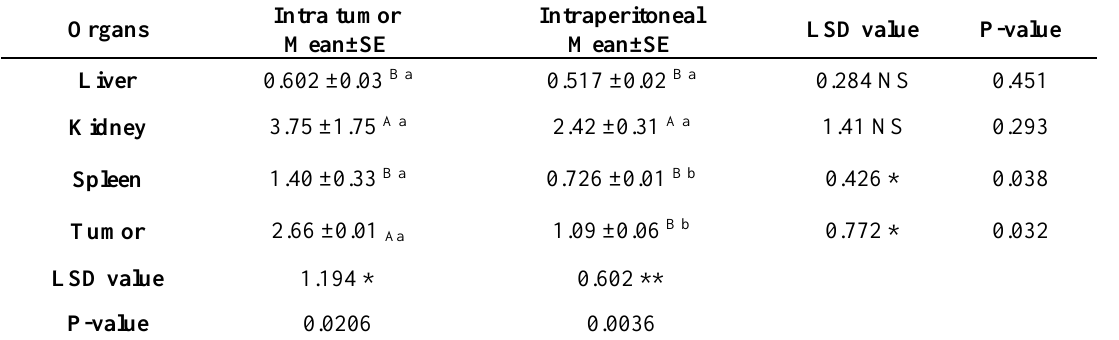
Table 1. Bio-distribution of GNPs ppm in tumor masses and various organs (comparison between IT and IP)